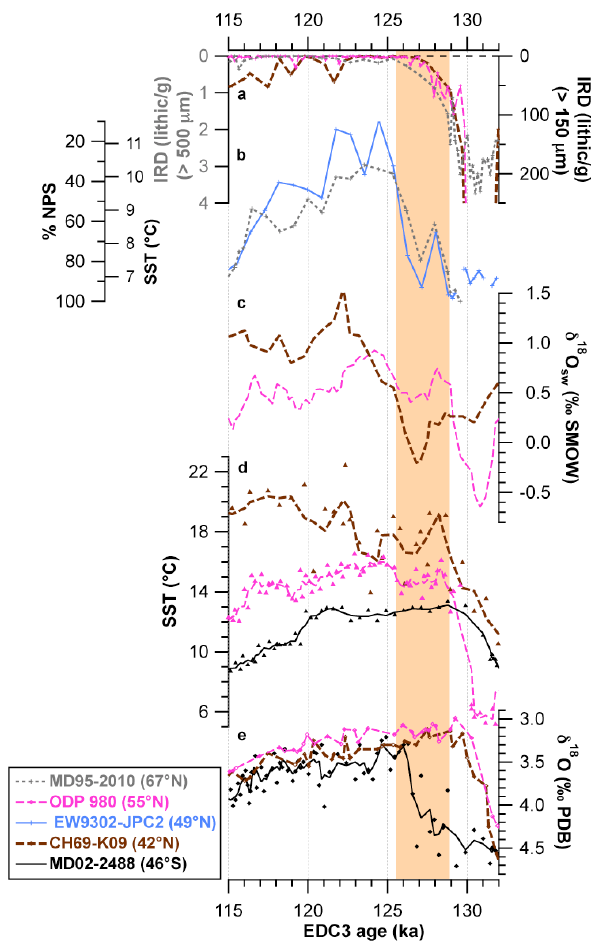
Fig. 7. Foraminiferal surface-water data over the period 132–115ka. (a) IRD, (b) percentage of the polar species N. pachyderma sinistral, (c) seawater δ 18 O ( δ 18 O sw ), (d) summer SST and (e) benthic δ 18 O records from the North Atlantic cores ODP 980 (dashed pink line) (Oppo et al., 2006) and CH69-K09 (dashed brown line) (Cortijo et al., 1999), the Norwegian Sea core MD95-2010 (dotted grey line) (Risebrobakken et al., 2006), the Labrador Sea core EW9302-JPC2 (Rasmussen et al., 2003a) (blue line), and the Southern Ocean core MD02-2488 (black line) (Govin et al., 2009). SST and Southern Ocean benthic records are 3-points smoothing curves. Seawater δ 18 O records are 5-points smoothing curves (see Fig. 2). The orange-shaded area highlights the period 129–125ka of the early LIG (see